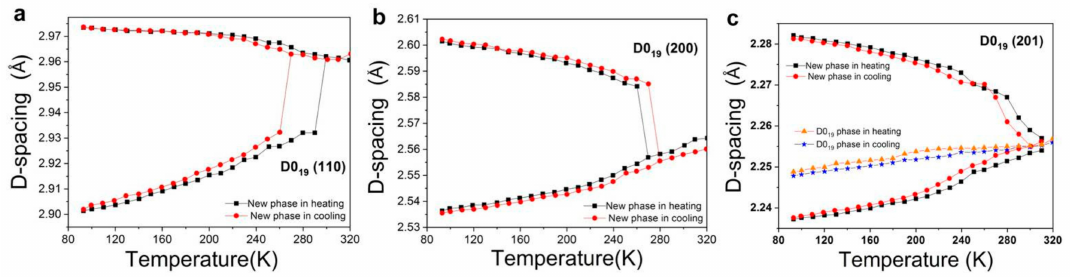
Figure 4. Lattice d-spacing variations of Ti 3 Sn powder during in-situ cooling and heating process. ( a ) D-spacing change of D0 19 -(110) plane; ( b ) d-spacing change of D0 19 -(200) plane; ( c ) d-spacing change of D0 19 -(201) plane in a temperature range of 93–320 K, respectively. The D0 19 (201) peak still existed after phase transformation to the lowest temperature of 93